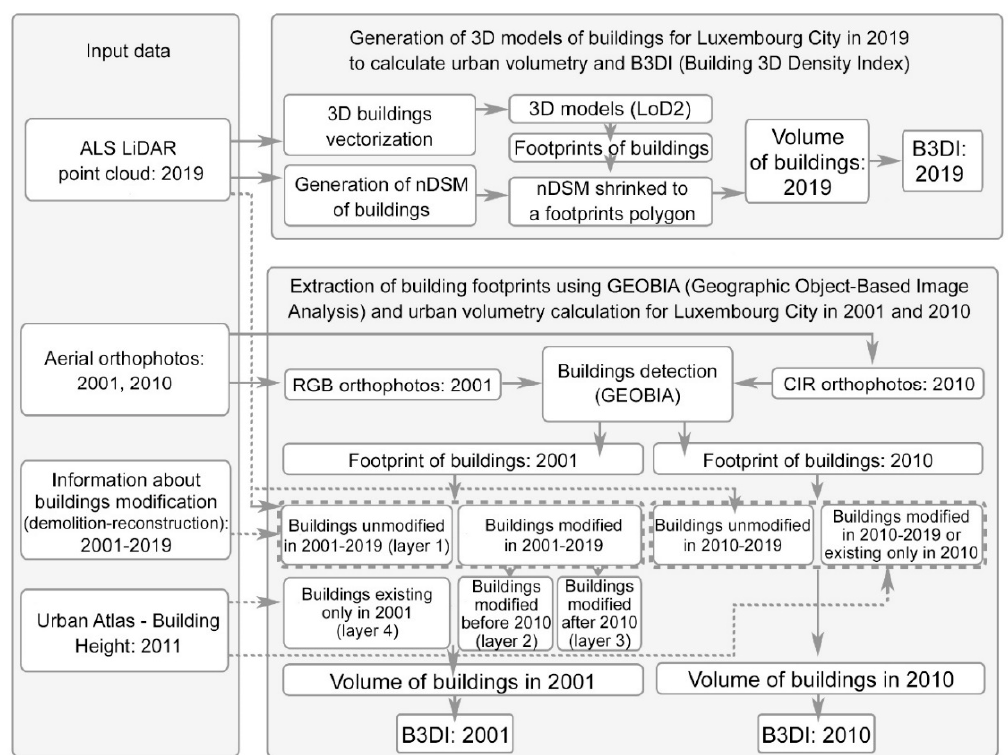
Figure 2. Workflow of the performed analyses (ALS—airborne laser scanning; nDSM—normalized digital surface model; LoD2—level of details 2; GEOBIA—geographic object-based image analysis; B3DI—Building 3D Density Index).